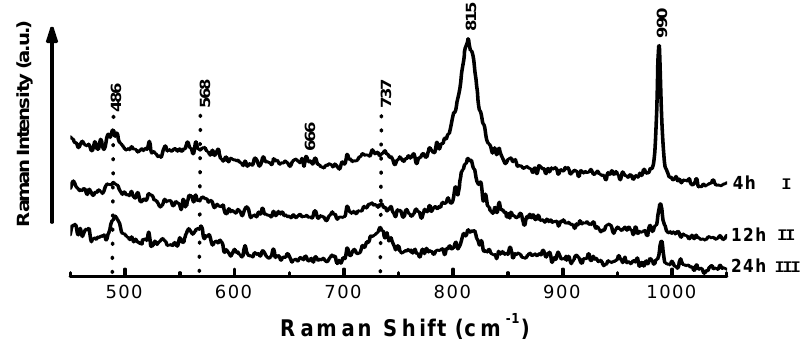
Figure 4. Raman spectra of the MoO 12 h (II) and 24 h